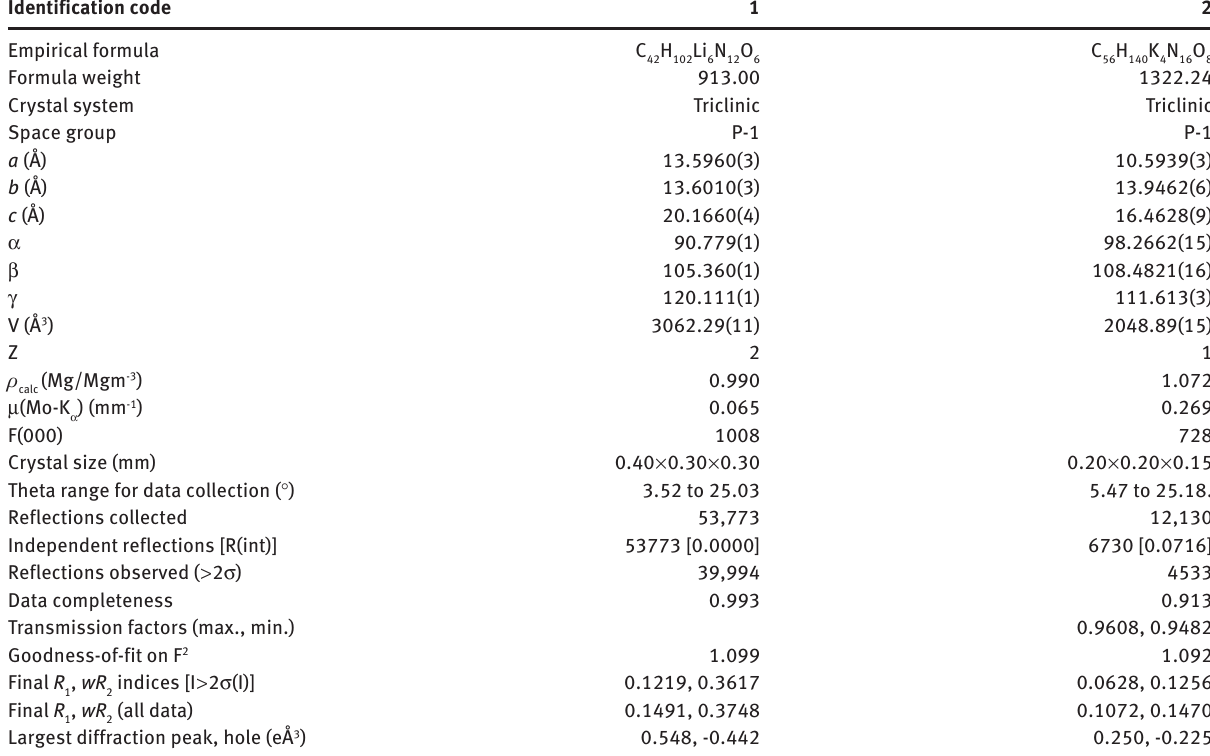
Table 1 Crystal data and structure refinement for compounds 1 and 2